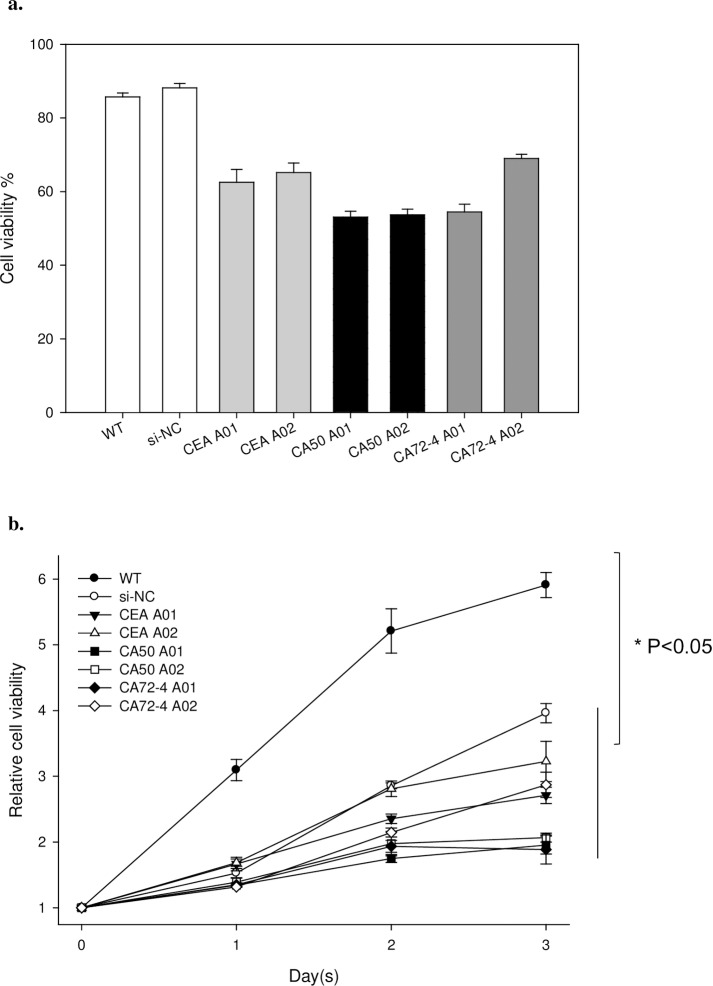
Inhibitory effects of selected aptamers on LS-174T cells.a) Cell viability determined by trypan blue staining 48-hour after the transfection; b) Relative cell growth rate monitored by the MTT assay from day 0 to day 3.